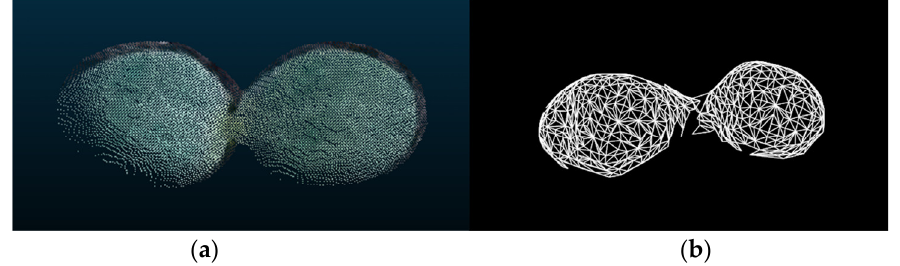
Figure 7. Leaf area detection schematic. ( a ) Point cloud map containing color information. ( b ) Greedy projection triangulation.